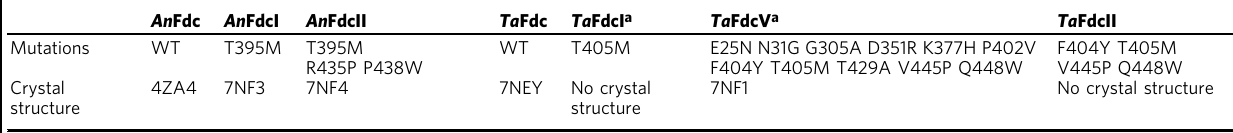
Table 1 Summary table of An Fdc and Ta Fdc